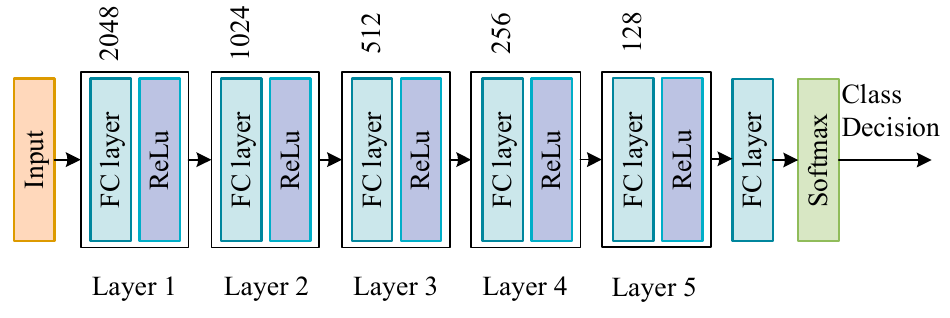
Figure 4. DNN model structure settings.